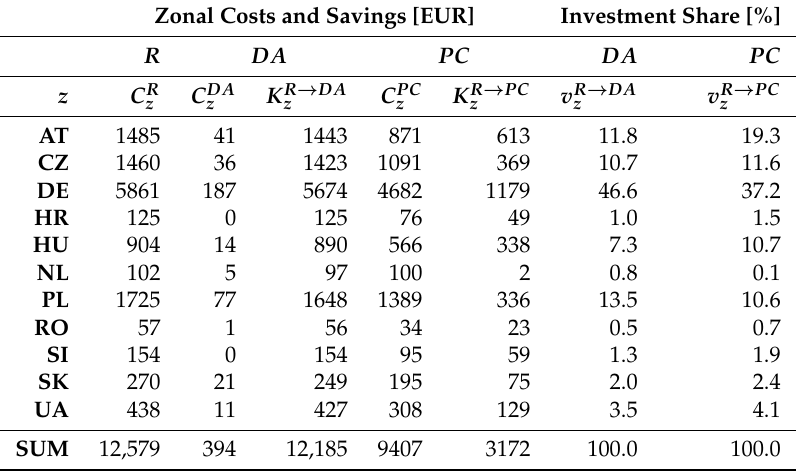
Table A2. Zonal costs ( C ), savings ( K ) and investment shares ( v